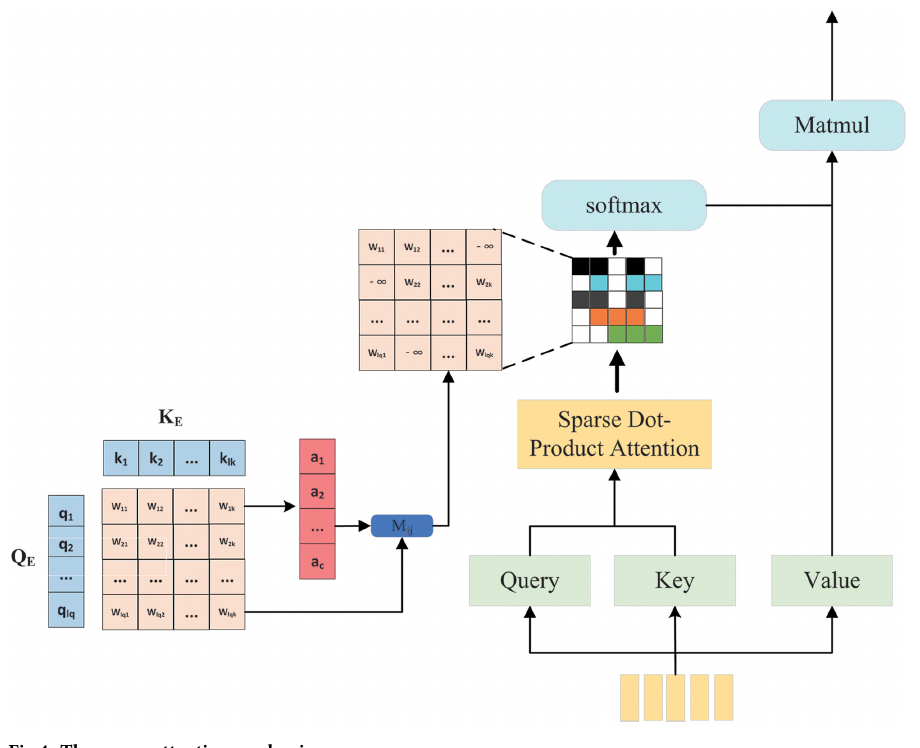
Fig 4. The sparse attention